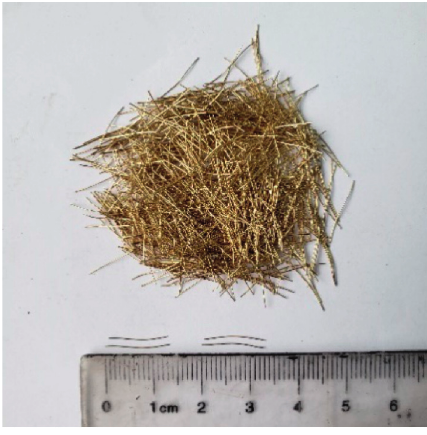
Figure 3: Steel fibers. Table 8: Physical properties of basalt fibers.